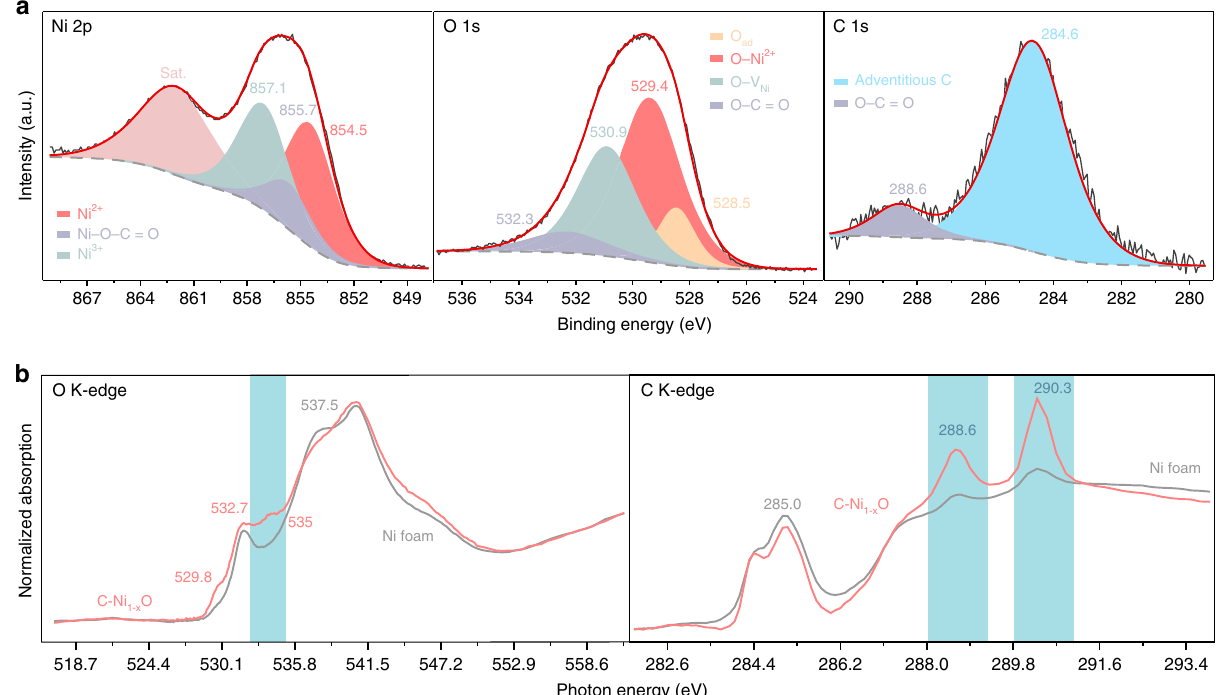
Fig. 3 Chemical environment of C – Ni 1 − x O. a Ni 2p, O 1s, and C 1s XPS spectra collected from C – Ni 1 − x O particles. The black curves are the experimental data. The red curves are the summation of the deconvoluted peaks (shaded regions). b O K-edge and C K-edge XANES spectra of C – Ni 1 − x O grown on NF (red curve) and NF (gray